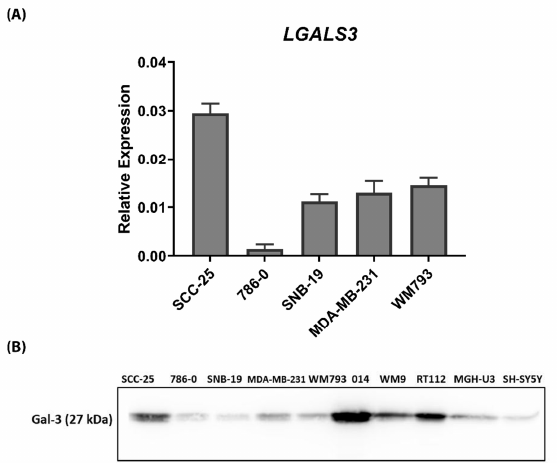
Figure 1. Expression of Gal-3 in human cancer cell lines. ( A ) Quantitative RT-PCR analysis of mRNA expression of Axl, MerTK, Tyro3, Gas6 and ProS1 in five human cancer cell lines. Bars are the mean ± SEM relative gene expression normalised against the housekeeping gene GAPDH ( n = 3 separate experiments). ( B ) Western blot screen of Gal-3 protein expression in ten human cancer cell lines. Equal amounts of total protein were loaded and blot probed with anti-Gal-3 antibody.